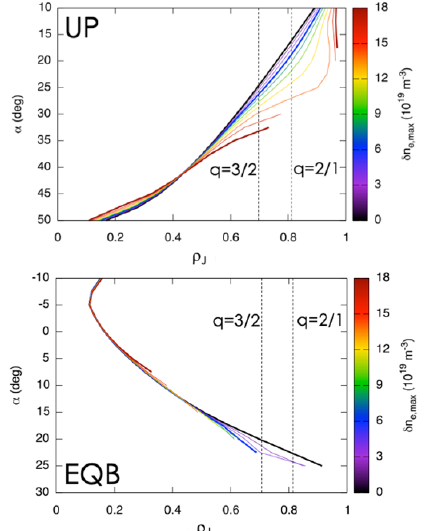
Fig. 4 . Poloidal angles a and relatives current density average location for upper (top: with toroidal angle b =15°) and bottom equatorial launchers (bottom: with toroidal angle b =5°). Colours refer to different density perturbation amplitude. Location of the rational q surfaces are shown by vertical dashed black lines.